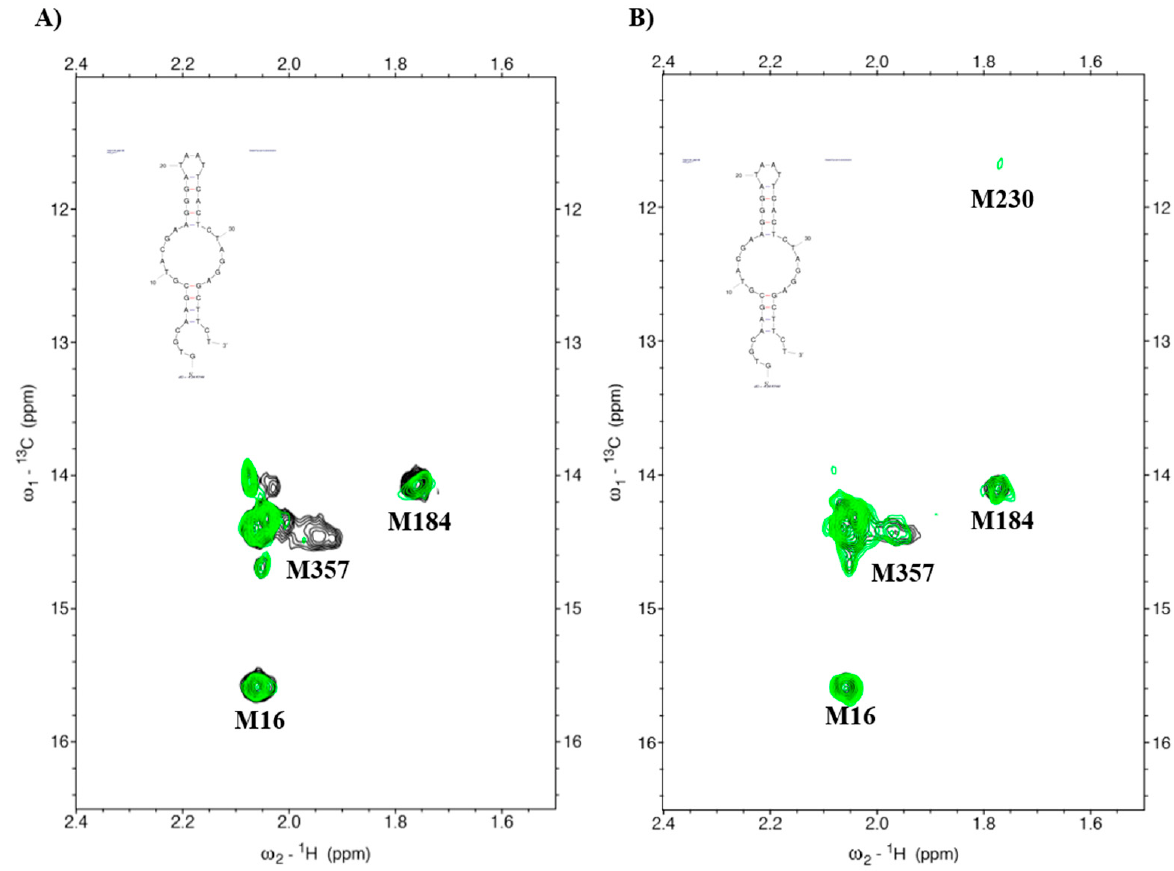
Figure 4. HSQC spectra of HIV-1RTs-aptamers. Black represents the HIV-1 RTs apo form. Green spectra represents the HIV-1 RTs-aptamer complexd. ( A ) WT HIV-1 RT complexed to the KY44 aptamer. ( B ) KY-mutant HIV-1 RT complexed to the KY44 aptamer.